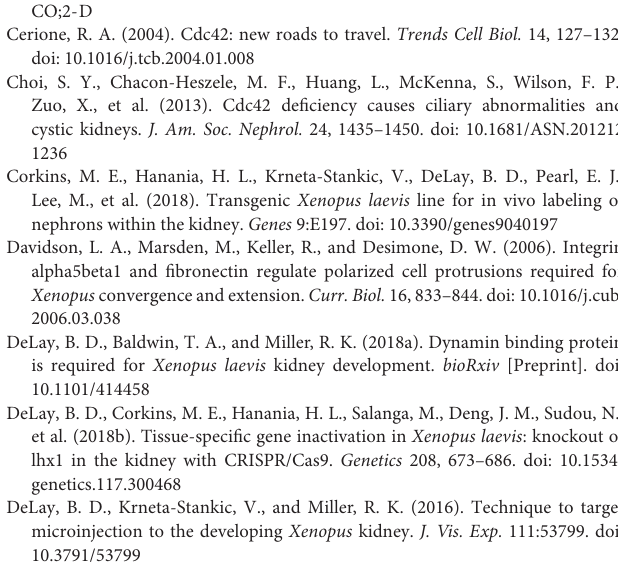
FIGURE S1 | In situ hybridization of both homeologs of dnmbp . Antisense probes (AS) labeling dnmbp expression in the pronephros, head structures and somites. Sense (S) probes shown as a control for non-specific probe binding were processed in parallel with the AS probes. Scale bar indicates 500 µ m. FIGURE S2 | Knockdown of Dnmbp results in reduced kidney tubulogenesis. (A) Unilateral injection of 20 ng Dnmbp MO 2 into blastomere V2 at the 8-cell stage leads to defects in kidney tubulogenesis in comparison to embryos injected with Standard MO. Antibody 3G8 used to label the lumen of the proximal tubule, antibody 4A6 used to label the distal and connecting tubules. memRFP used as an injection tracer. White bar indicates 200 µ m. ∗ Indicates injected side of embryo. (B) Knockdown of Dnmbp leads to reduced expression of differentiated kidney tubule markers in comparison to embryos injected with Standard MO. n = number of embryos across 3 replications. Error bars represent Standard error. ∗ Significantly different from control, p < 0.05. FIGURE S3 | Primers used to amplify regions of dnmbp for TIDE analysis. (A) DNA sequence of the region surrounding exon 3 of dnmbp.L indicating sgRNA and sequencing primer binding sites. (B) DNA sequence of the region surrounding exon 3 of dnmbp.S indicating sgRNA and sequencing primer binding